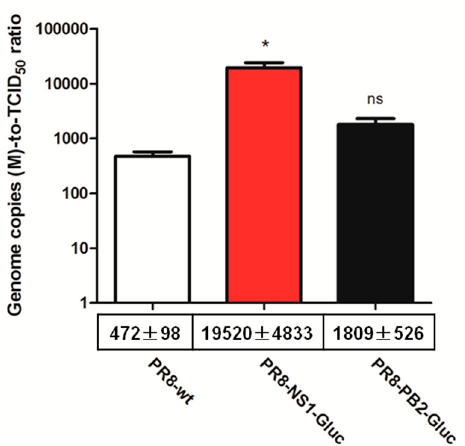
Figure 2. Relative genome copies-to-TCID 50 ratio of reporter IAVs PR8-NS1-Gluc and PR8-PB2-Gluc. Indicated viruses derived from MDCK were titrated and extracted for vRNAs followed by quantification of segment M by qPCR. The genome copies-to-TCID50 ratio were evaluated. The standard deviations were calculated based on three replicates. * p < 0.05; ns, no significance, students’ t test.